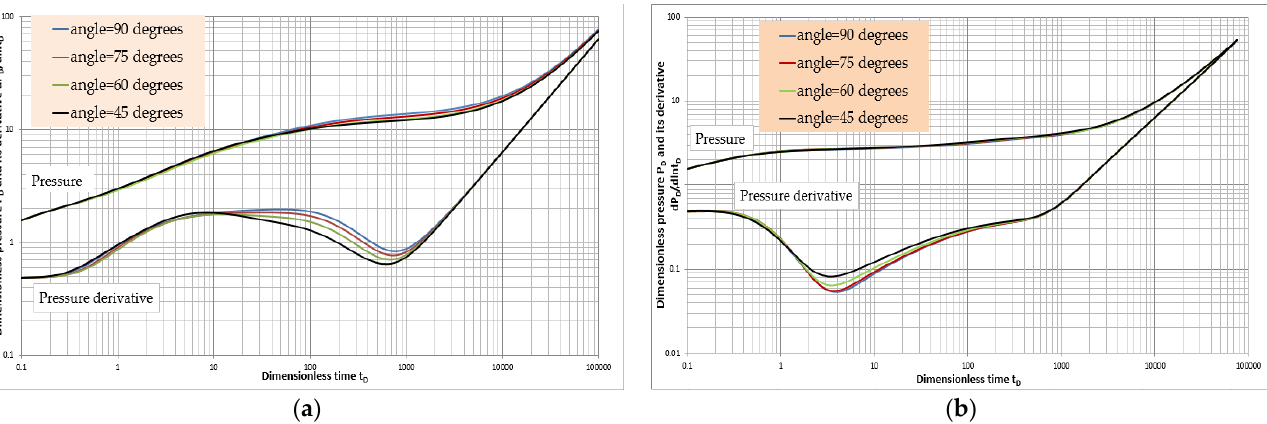
Figure 15. Pressure and its derivative behaviors of a well for different fracture crossing angles under ( a ) k frac / k matrix = 1.0 × 10 − 4 and ( b ) k frac / k matrix = 1.0 × 10 4 , with W D = 50, H D = 50, L D = 15, 2 L fD = 20, d D = 1, and w fD =